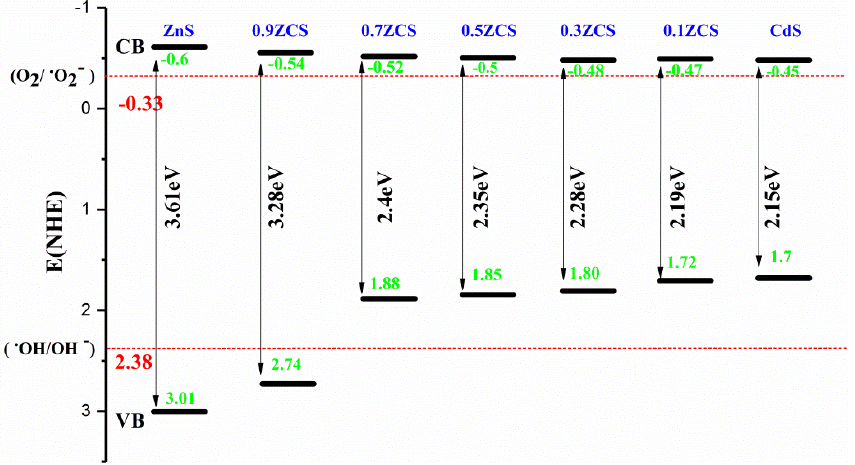
Figure 6. The conduction and valence band potentials of the prepared ZCS samples.